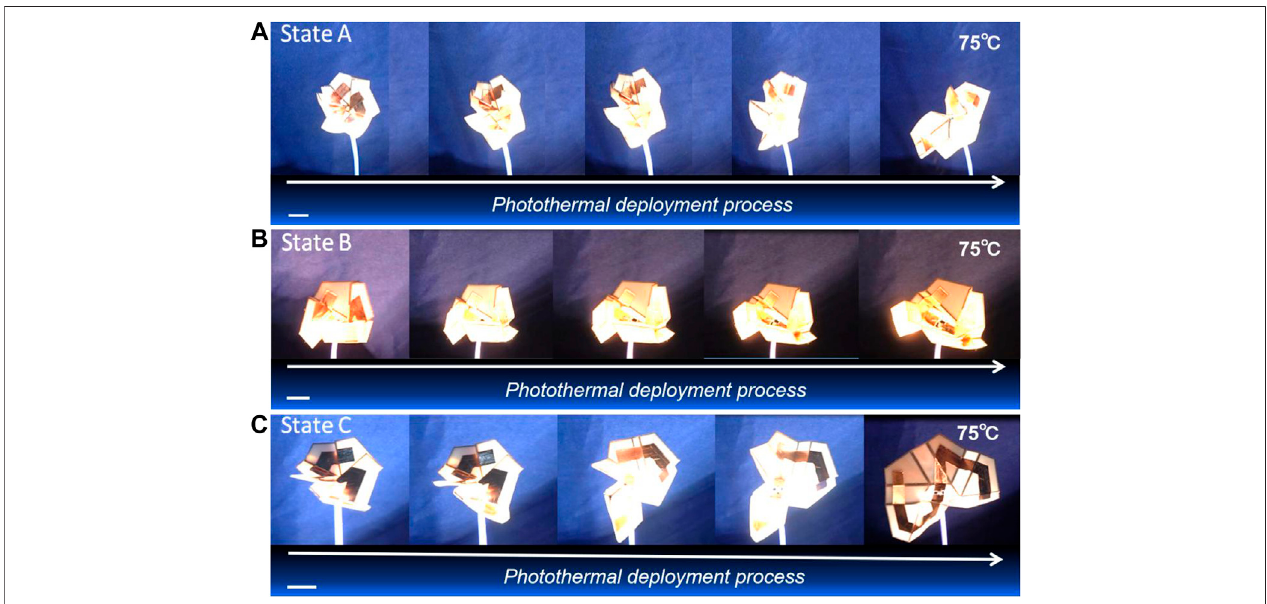
FIGURE 9 | The self-deployment process of hexagon-twist frequency recon fi gurable antenna with (A) state A, (B) state B and (C) state C under photothermal condition. Scale bar, 30 mm.